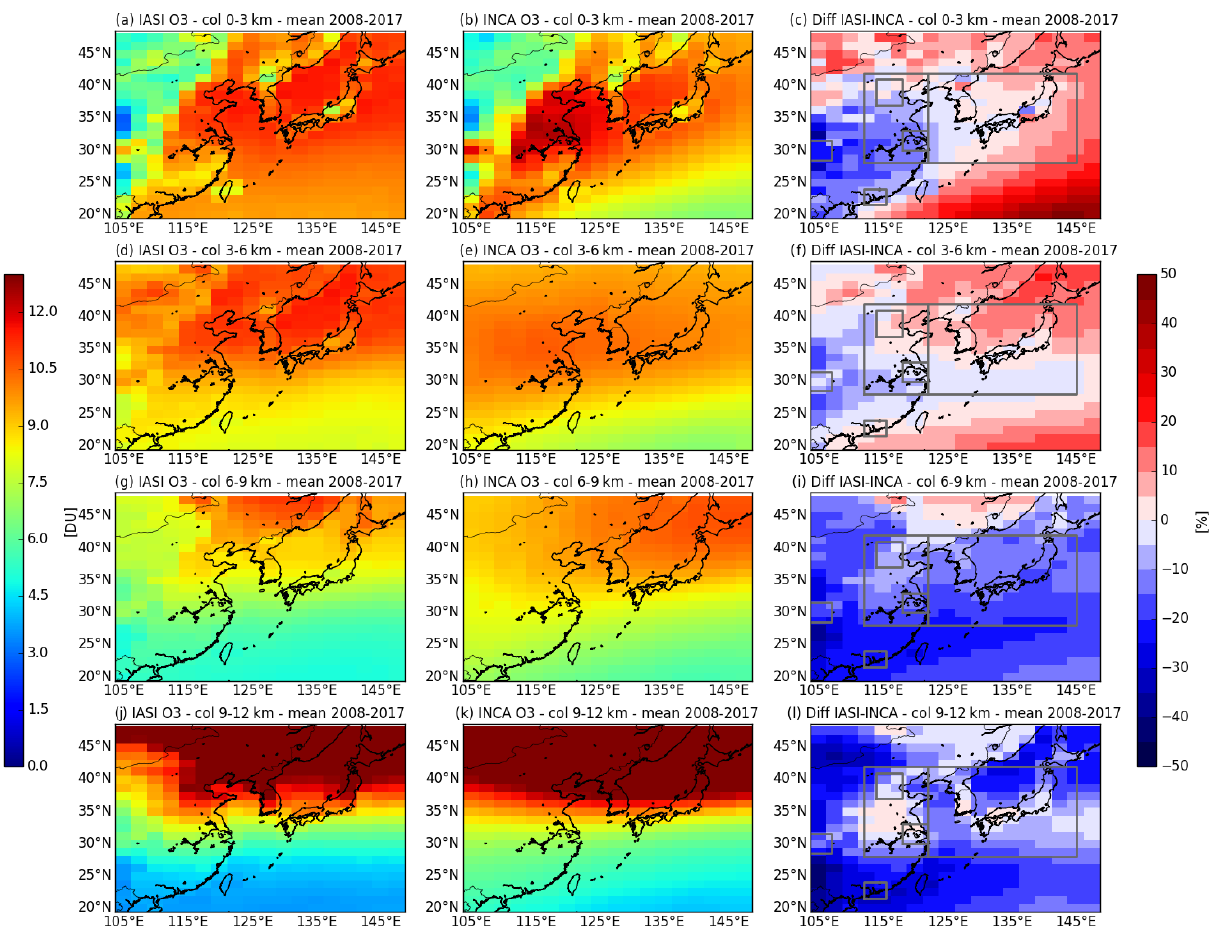
Figure A3. Mean O 3 partial columns for 2008–2017 observed with IASI ( a , d , g , and j ), simulated by INCA ( b , e , h , and k ), and their differences ( c , f , i , and l ). The following four different partial columns are considered: 0–3, 3–6, 6–9, and 9–12km columns.